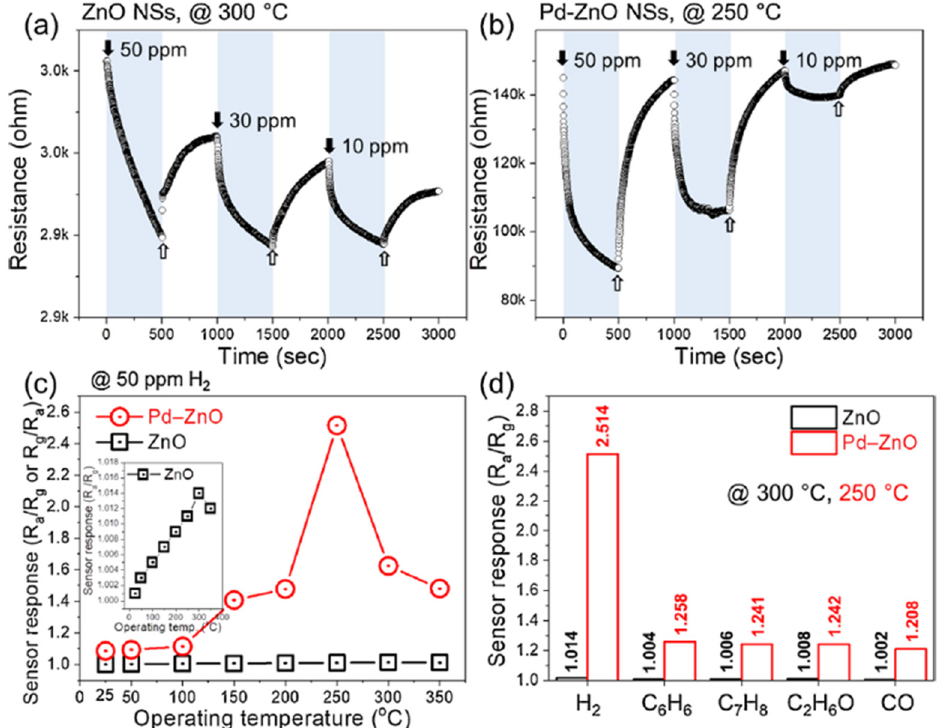
Figure 29. Dynamic resistance curves of ( a ) pristine and ( b ) Pd-decorated ZnO nanosheets to H 2 gas. ( c ) The response of pristine and Pd-decorated ZnO nanosheets to 50 ppm of H 2 gas at different sensing temperatures. The inset shows the response of a pristine sensor to H 2 gas and ( d ) selectivity patterns of ZnO and Pd-decorated ZnO nanosheet at optimal temperatures [122]. Copyright (2021), with permission from Elsevier.